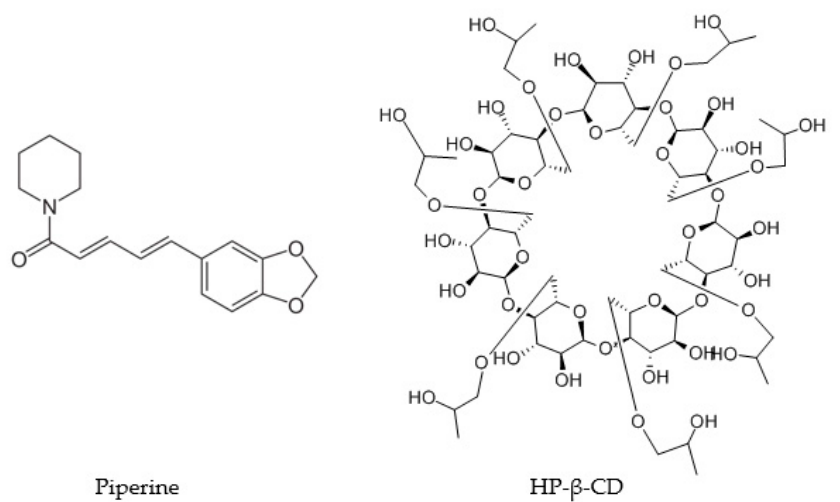
Figure 1. The structure of piperine and combination of piperine with 2-hydroxypropyl- β -cyclodextrin (HP- β -CD).